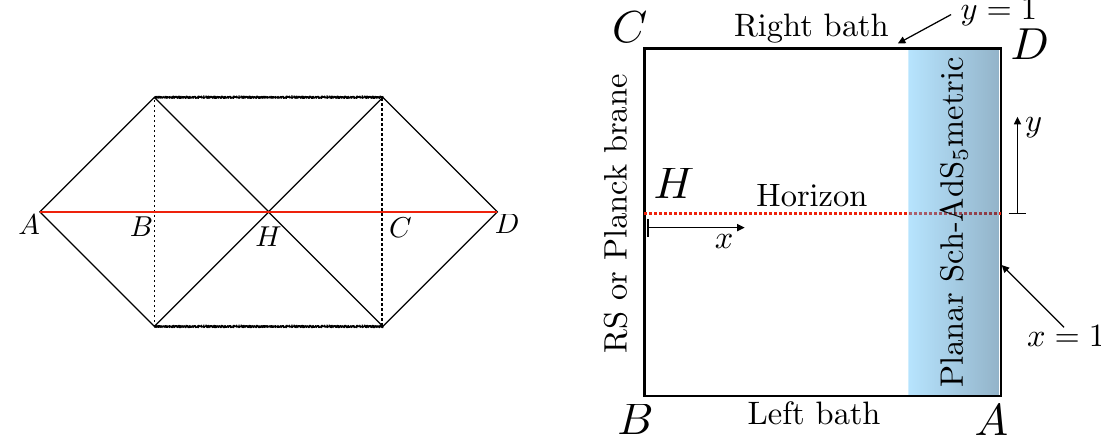
Figure 2: On the left, we show the Penrose diagram of the 4d geometry. We have a two-sided AdS black hole, with each side coupled to a bath. On the right, we show the integration domain used in the numerics x ∈ ( 0,1 ) and y ∈ ( − 1,1 ) . The objective is to solve for five metric functions Q ,..., Q of two variables each (17), 1 5 in this domain. We numerically solve only in the region y > 0, the rest is obtained simply by symmetry. On the left edge of this diagram, at x = 0, we have the RS or the Planck brane where the 4d gravity region lives and the boundary condition (3) is imposed. On the top and bottom edges we have the two baths. As x → 1, the metric approaches that of a 5d planar AdS-Schwarzschild black hole. The reader might find it useful to note the points ABHCD on both diagrams. The precise induced geometry on the segment BC is determined by the numerical solution, and the left picture is just a